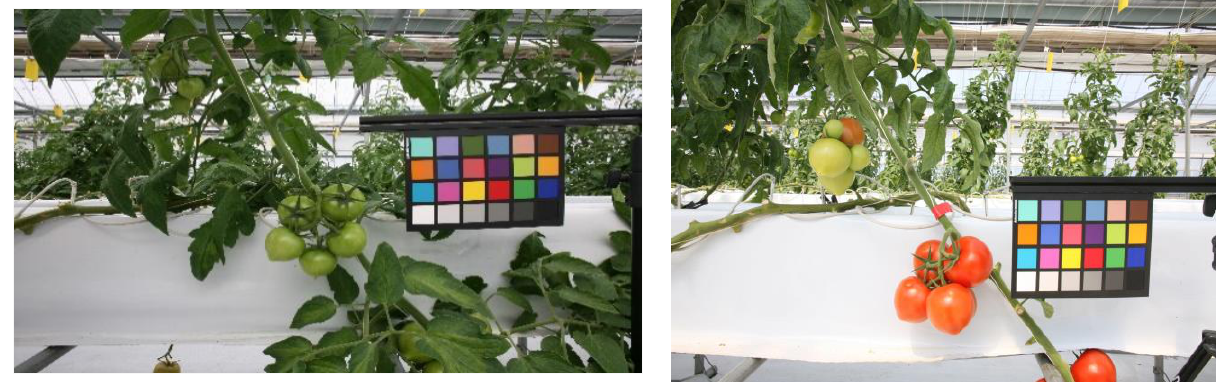
Figure 5. Examples of the acquired images.